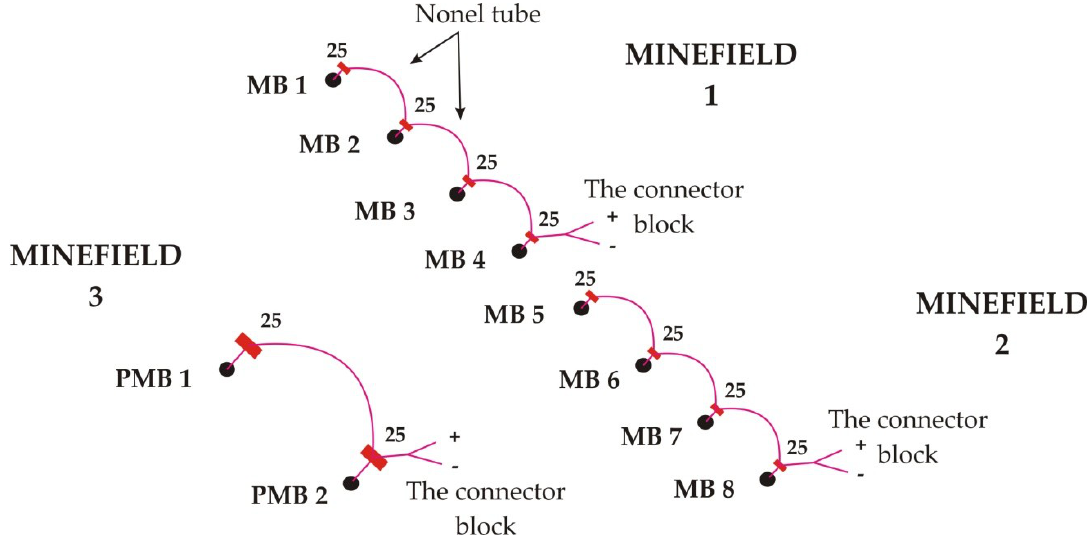
Figure 7. Schematics of blasting area with position of boreholes.